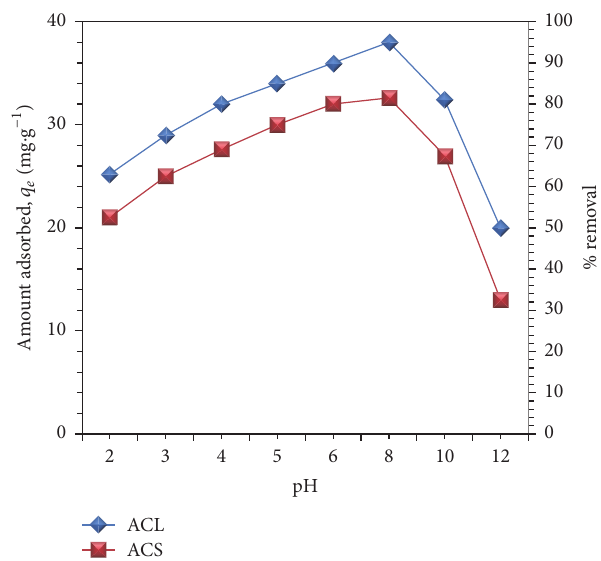
Figure 6: Effect of pH on the adsorption capacity and % removal of ACL and ACS sample ( 𝑇 = 25 ∘